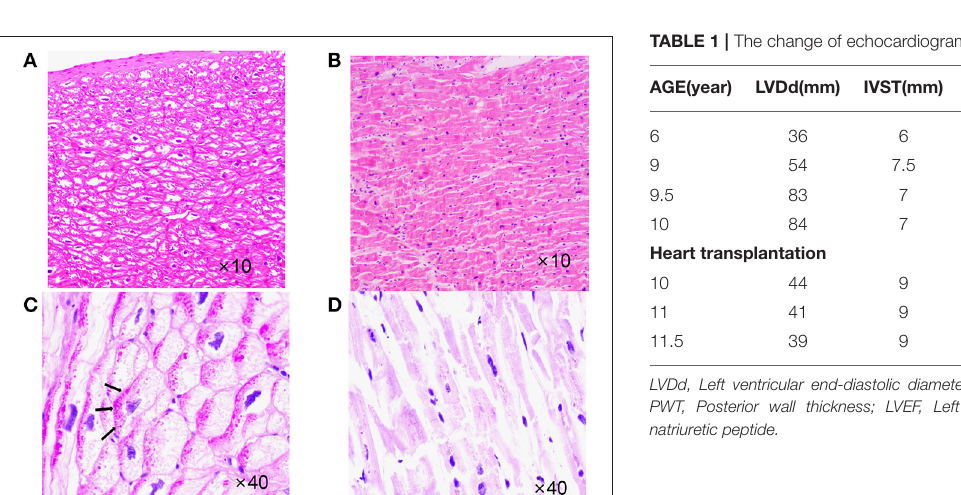
FIGURE 4 | Image of case 3 (III-7). (A) ECG before heart transplantation showed frequent ventricular premature contractions with narrow QRS. (B) Echocardiogram findings of changes in heart size before and after heart transplantation. (C) X-ray findings of changes in heart size before and after heart transplantation. (D) The enlarged specimen of the heart. (E,F) ECG in the first and second years after heart transplantation,T wave was inverted.